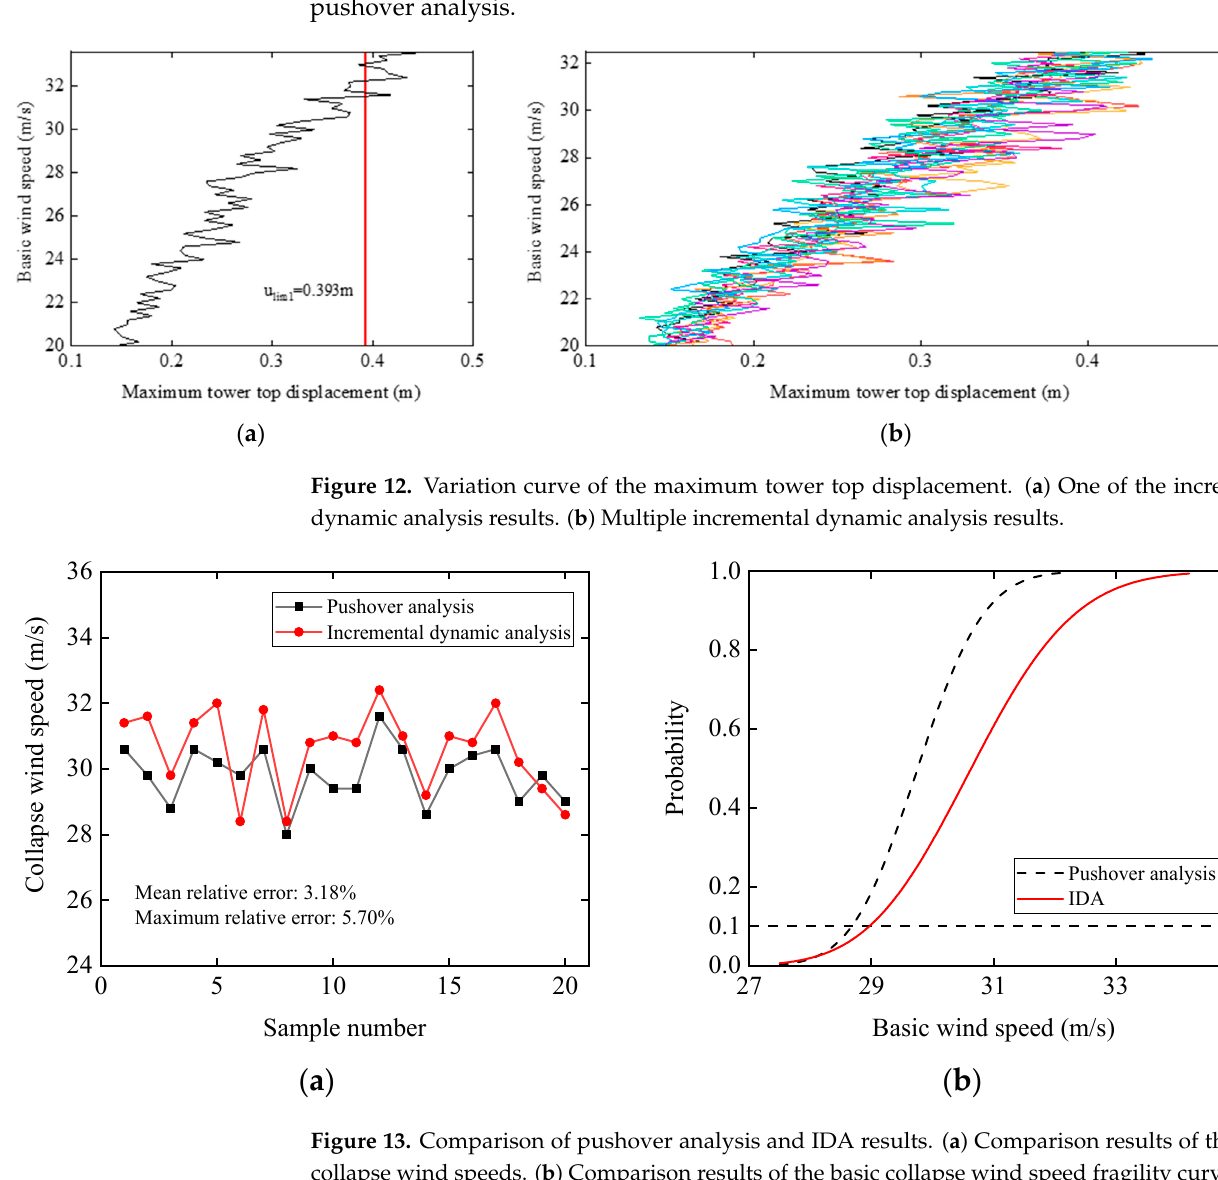
two methods were similar, with a maximum relative error of 5.7% and a mean relative error of 3.18%, indicating that the mass and coherence functions were considered when calculating the equivalent wind load according to the load code for the design of the overhead transmission line [35]; therefore, accurate response results can be obtained using pushover analysis. Figure 12. Variation curve of the maximum tower top displacement. ( a ) One of the incremental dy- namic analysis results. ( b ) Multiple incremental dynamic analysis results.